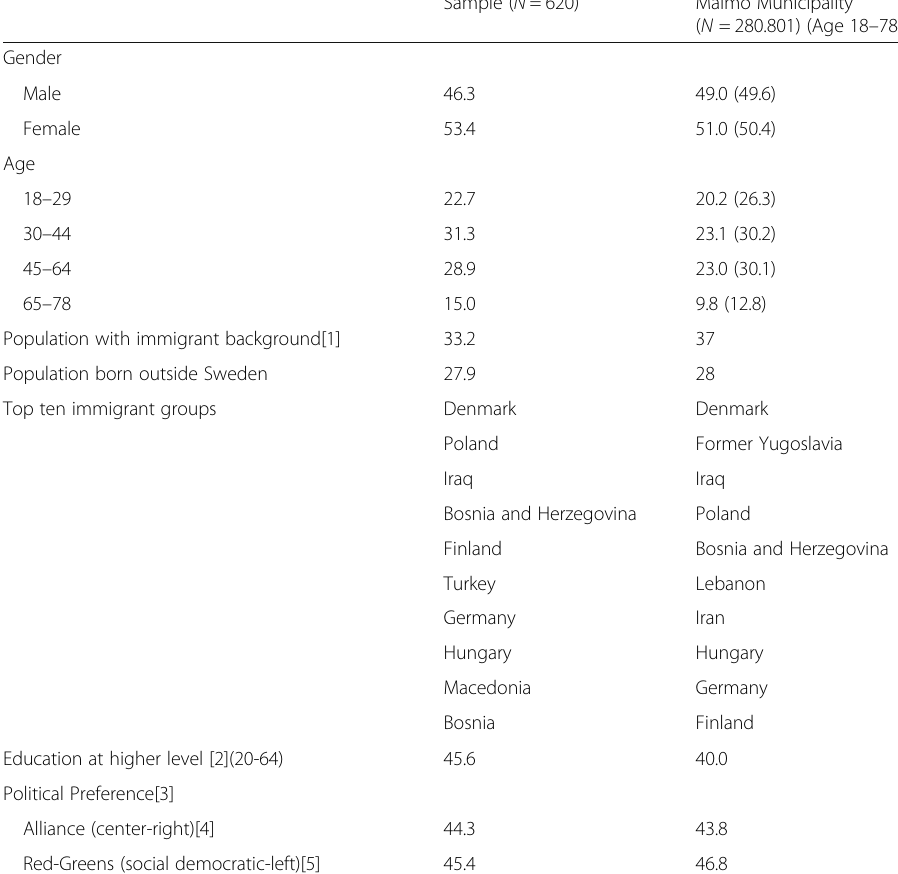
Table 1 Descriptive characteristics of the sample compared to the whole of Malmö